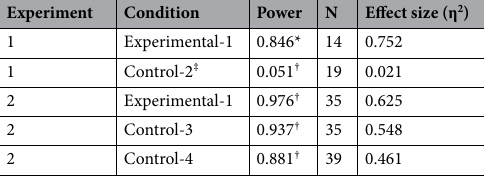
Table 1. Post-hoc power analyses for Figs. 1 and 2 for p = 0.05 (1-tailed). *Against mean observed change in control-2 condition. † Against 0 change. ‡